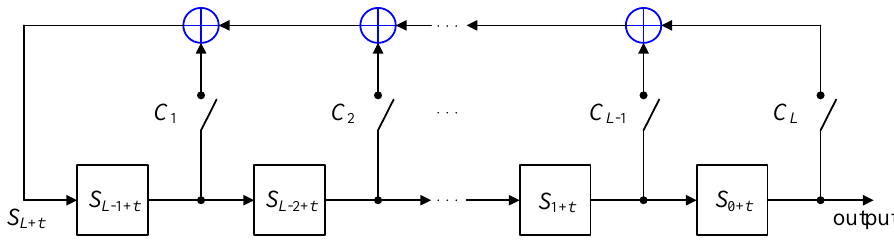
Figure 1. The Fibonacci structure of a LFSR.